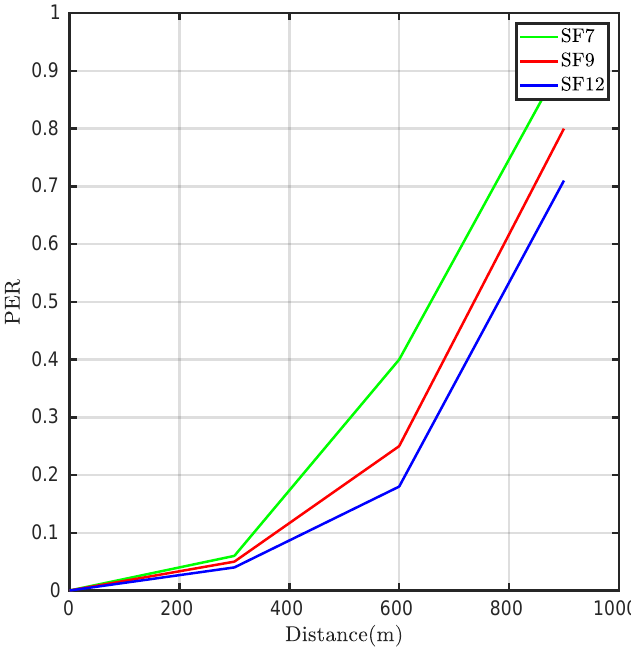
Figure 19. Error rate between sensor nodes and the gateway. Table 4. Average time and error rate in the Zigbee–LoRaWAN link. Spreading Factor Range